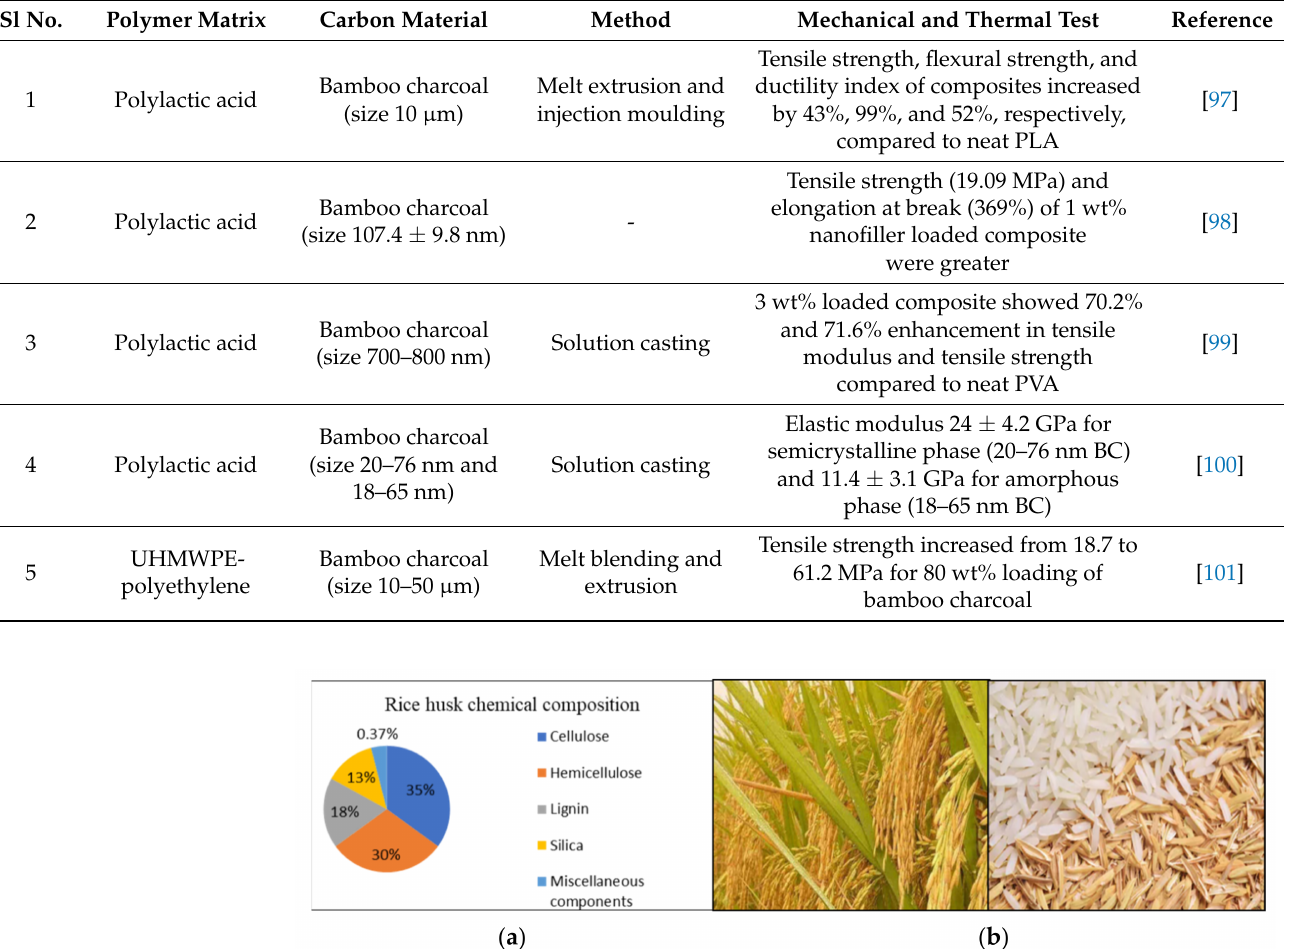
Figure 24. ( a ) Rice husk chemical composition and ( b ) rice plant, grain, and